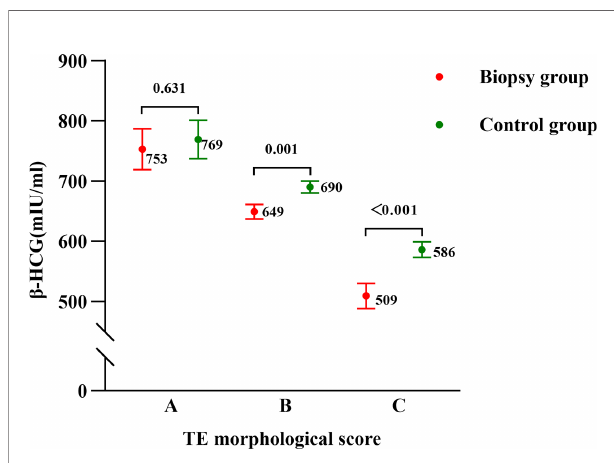
FIGURE 1 | Serum b -HCG levels on the 12th day after blastocyst transfer in the biopsy and control groups as strati fi ed by morphological TE scores. Points and errors bars represent marginal means and standard errors,